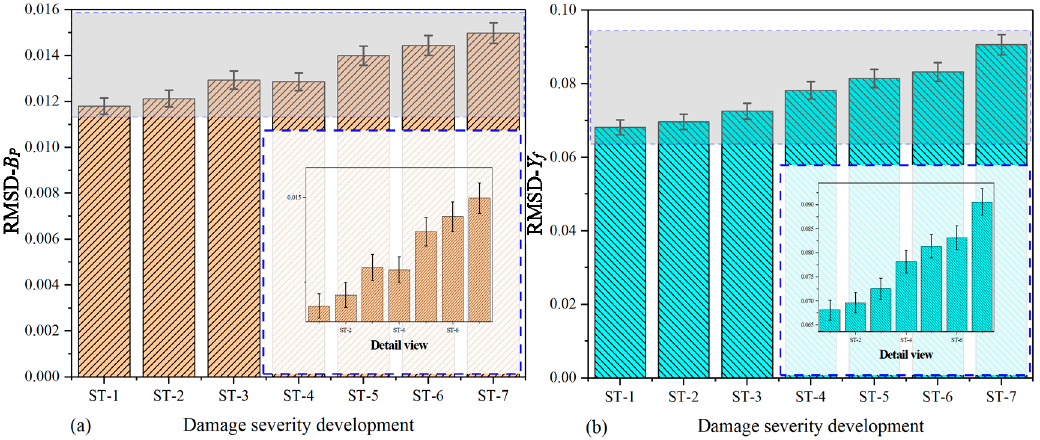
Figure 12. RMSD based on imaginary part of signatures for specimen-2: ( a ) raw susceptance signatures B , ( b ) extracted DCMI signatures Y .